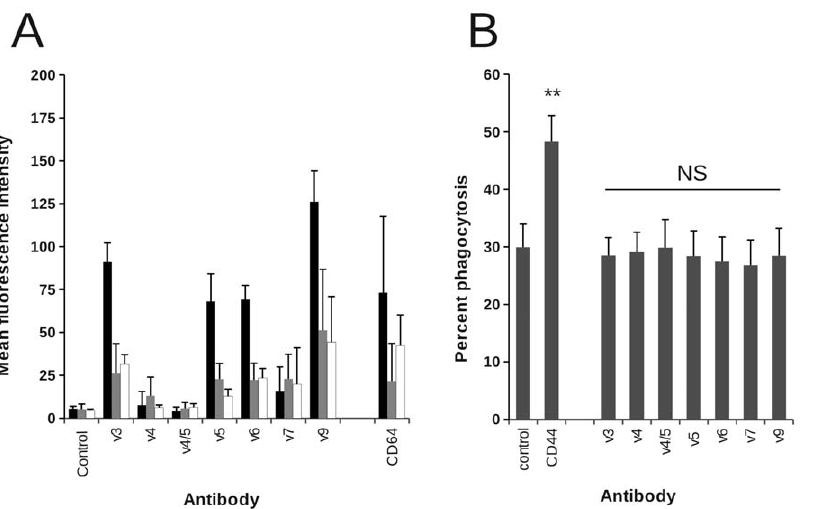
Figure 2. CD44 variant antibodies do not promote phagocytosis of apoptotic PMN. A) Monocytes (white bars) or monocyte-derived macrophages cultured for 5 days in the absence (black bars) or presence of dexamethasone (gray bars) were incubated with different isoform-specific CD44 mAb or CD64 mAb (10.1) for 30 min to allow saturation of binding prior to addition of FITC-conjugated F(ab 9 ) 2 goat anti-mouse immunoglobulins and assessment of binding by flow cytometry. Data shown are the average mean fluorescence intensity 6 SEM for 4 independent experiments. B) Monocyte-derived macrophages were incubated with isoform-specific CD44 mAb for 30 min to allow saturation of binding prior to addition CMFDA-labelled apoptotic targets at 37 u C for the times indicated. Assessment of phagocytosis was made by flow cytometry. Data shown are mean percent phagocytosis 6 SEM from 4 different macrophage preparations, no significant augmentation of phagocytosis compared with control was observed with any of the variant antibodies examined (NS).